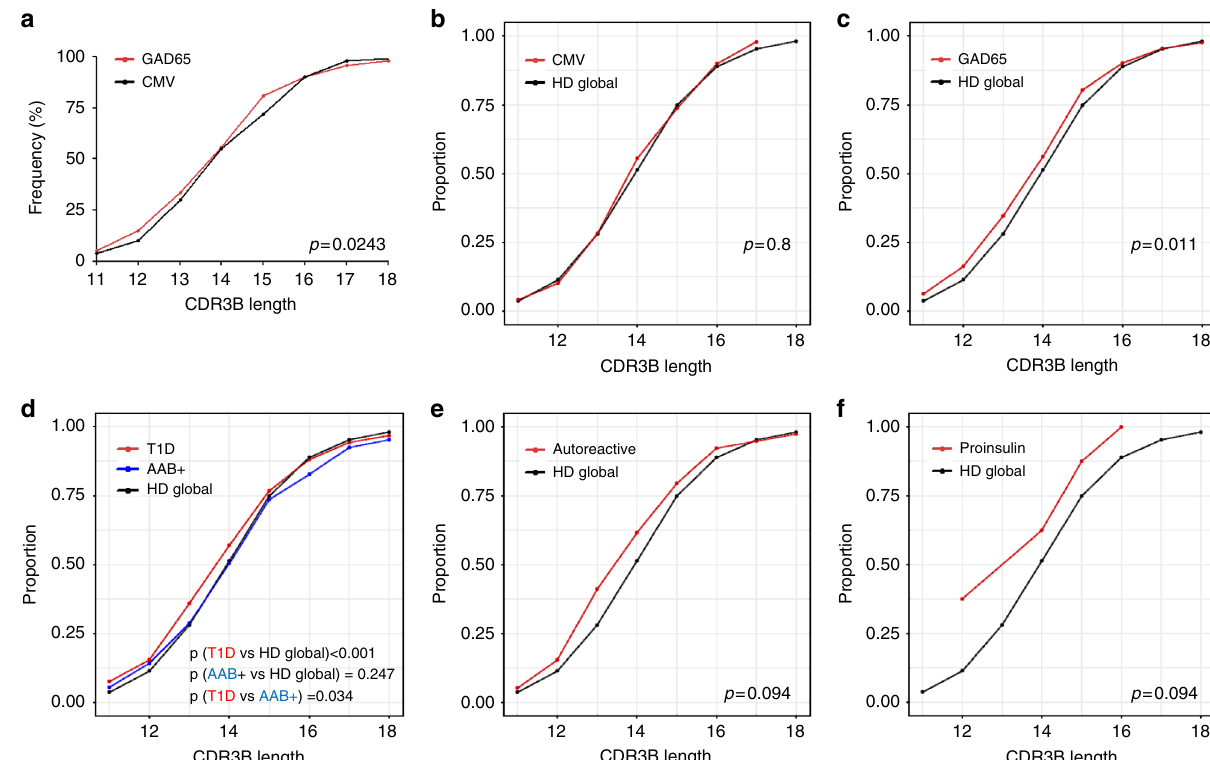
Fig. 8 Autoreactive clonotypes show TCRB CDR3 length shortening. a Cumulative plots of glutamic acid decarboxylase 65 (GAD65)-speci fi c ( n = 374) versus cytomegalovirus (CMV)-speci fi c ( n = 122) TCRB clonotypes. b Cumulative plots of CMV-speci fi c TCRB clonotypes versus healthy donor global TCR repertoire. c Cumulative plots of GAD65-speci fi c TCRB clonotypes versus healthy donor global TCR repertoire. d Cumulative plots of GAD65-speci fi c clonotypes of type 1 diabetes (T1D) patients from the literature ( n = 479) versus GAD65-speci fi c clonotypes of non-diabetic autoantibody-positive patients ( n = 387) versus healthy donor global TCR repertoire. e Cumulative plots of T1D autoreactive clones described in the literature ( n = 39) versus healthy donor global TCR repertoire. f Cumulative plots of intra-islet proinsulin-speci fi c clonotypes ( n = 8) versus healthy donor global TCR repertoire. a – f : One- sided bootstrapped Kolmogorov – Smirnov